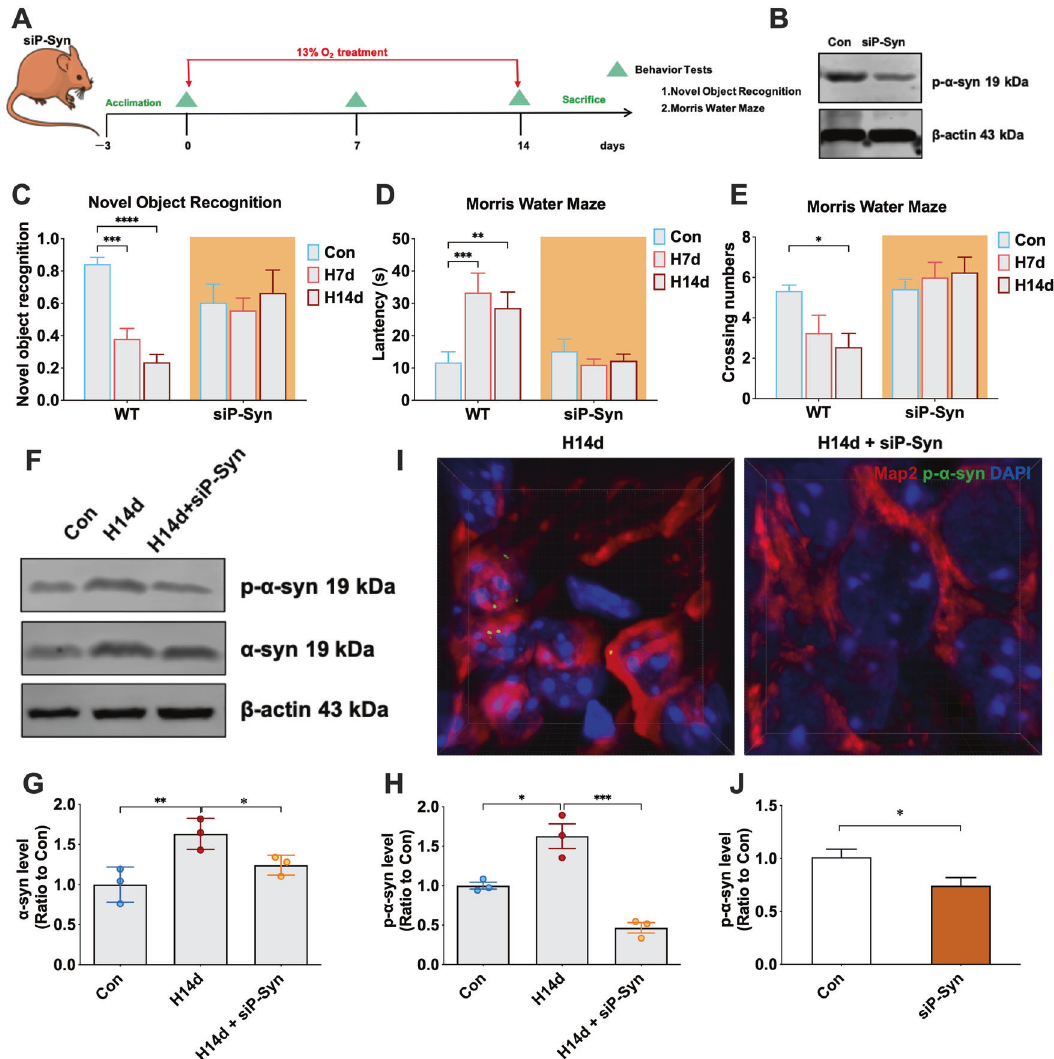
Fig. 4 Mice administered with competing peptides targeting ser129 resist chronic hypoxia-induced cognitive impairment. A , B , J Mice were administered competing peptides targeting ser129 and then received continuous hypoxia-inducing treatment for 0, 7, and 14 days (Con, H7d, and H14d) before undergoing behavioral tests at different time points. C Detection and statistical analysis of the novel object recognition tests in mice of each group. D , E Detection and statistical analysis of the Morris water maze tests in mice of each group. F – H The levels of p- α - syn and α -syn in the hippocampi of mice in the Con, H14d, and H14d + siP-Syn groups were detected by western blots with β -actin as the internal reference; statistical analysis was performed. I The high-power three-dimensional imaging of p- α -syn immuno fl uorescence. In C – E , data are expressed as the mean ± SEM (two-way ANOVA), * P < 0.05, ** P < 0.01, *** P < 0.001, **** P < 0.0001, n = 10. In G – H , data are expressed as the mean ± SEM (one-way ANOVA), * P < 0.05, ** P < 0.01, *** P < 0.001, n = 3. In J , data are expressed as the mean ± SEM (unpaired t -test), * P < 0.05, n =